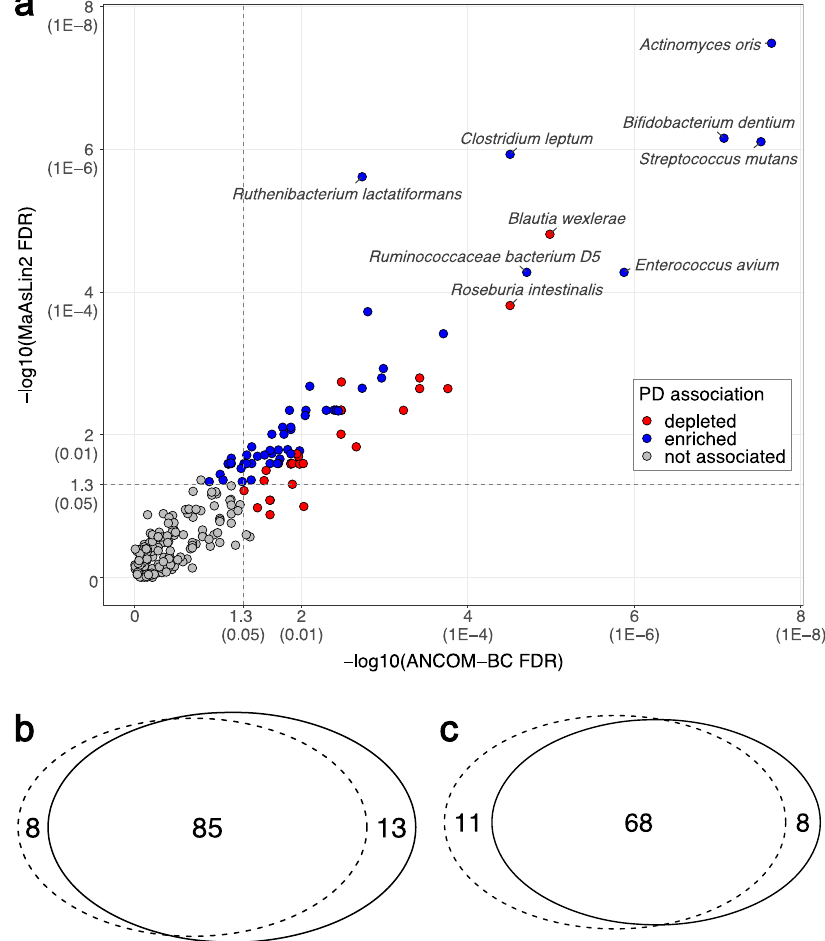
Fig. 2 | PD-associated species nominated by consensus of MaAsLin2 and ANCOM-BC. Analysisincluded N =724biologicallyindependentsamplesfrom490 PD and 234 neurologically healthy control (NHC) subjects. a 257 species (denoted by circles in the plot) were tested in microbiome-wide association study (MWAS) with two statistical methods: MaAsLin2 and ANCOM-BC. The results are shown according to signi fi cance ( − log10 of the FDR) achieved by MaAslin2 ( Y -axis) vs ANCOM-BC ( X -axis). Corresponding untransformed FDR values are provided in parentheses on the X and Y axes for easier interpretation. 84 species were nomi- nated as PD-associated, de fi ned by FDR<0.05 by one method and FDR ≤ 0.1 by the